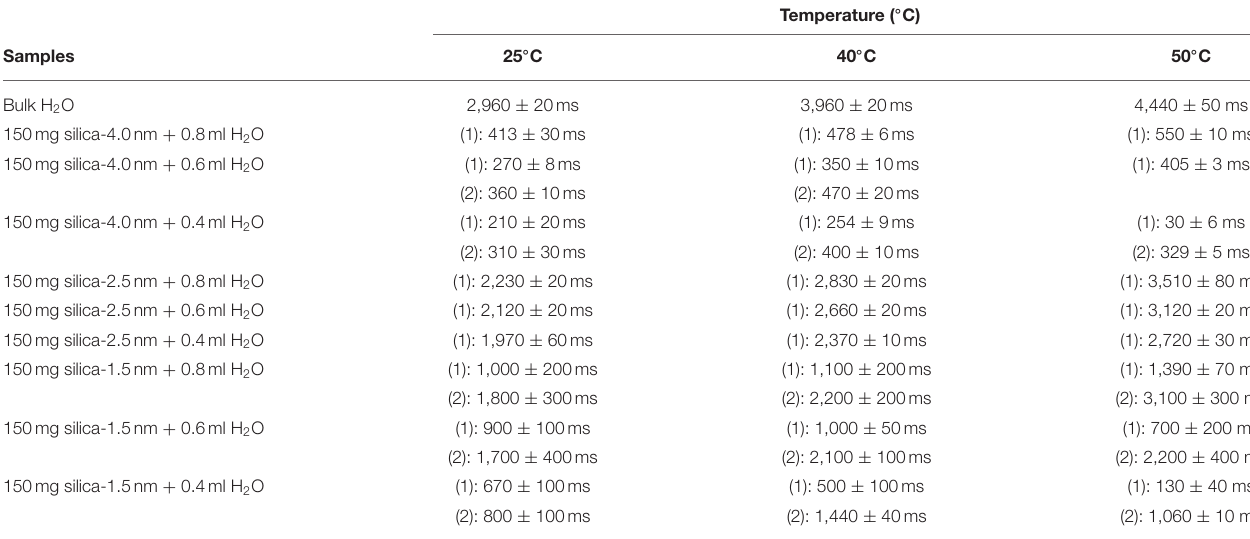
TABLE 4A | Longitudinal magnetization relaxation times (T 1 ) of confined water obtained after sonication of the mixtures for 15 min.